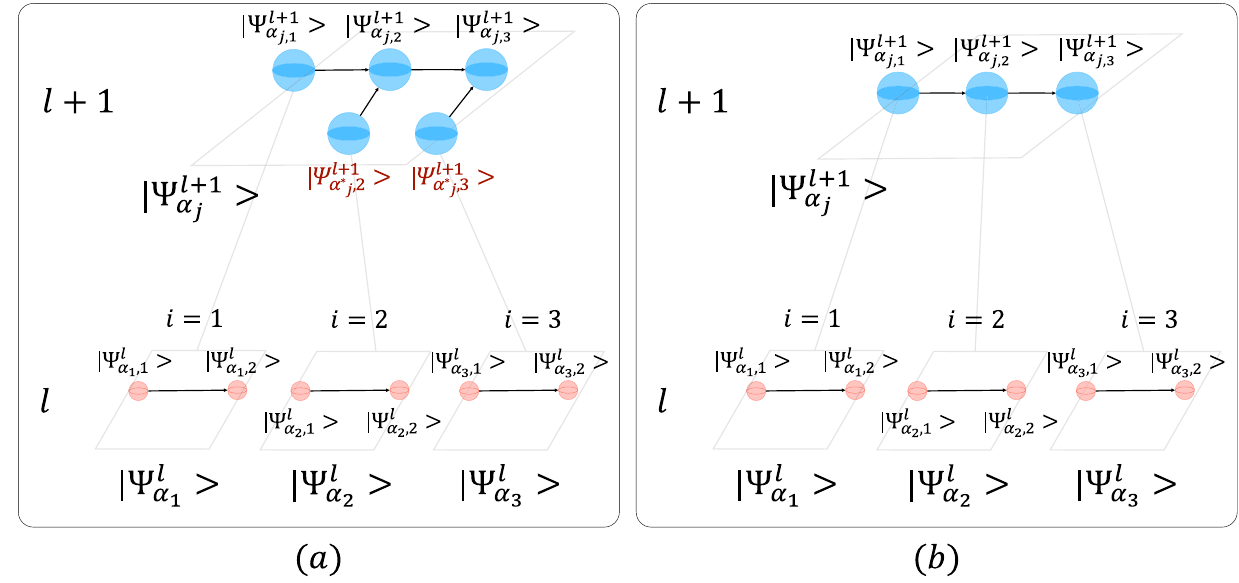
Figure 2. Aggregation of two layers network. Three qubits case. ( a ) First approach ( b ) Second approach. Each node (circle) of the network is represented by a qubit (e.g., sensor qubit in level l and machine qubit in level l + 1 ). Interactions between nodes (qubits) are represented by edges in the direction of